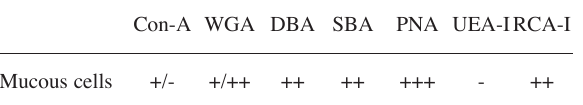
moderate, +++ strong. When two symbols are employed, for example +/-, they indicate